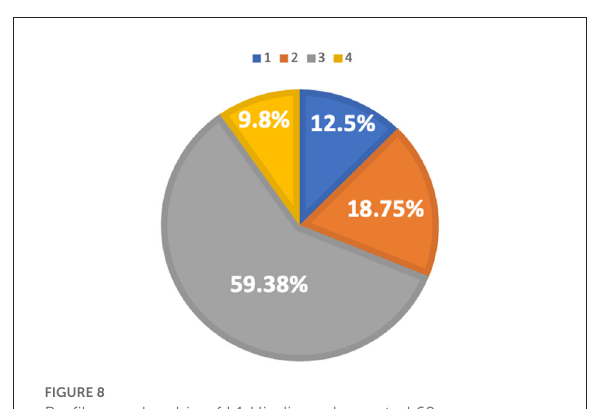
FIGURE8 Profile membership of L1 Hindi speakers rated 60.